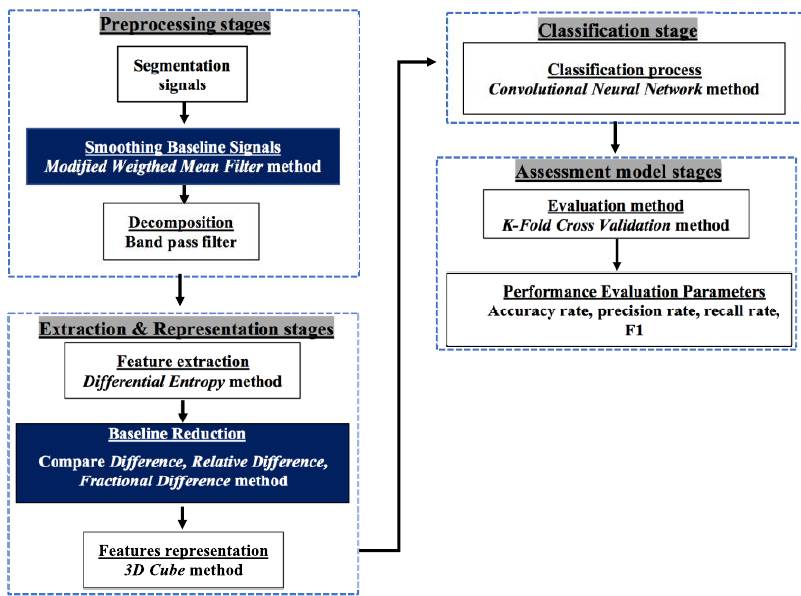
Figure 5. Emotional recognition is based on EEG signal